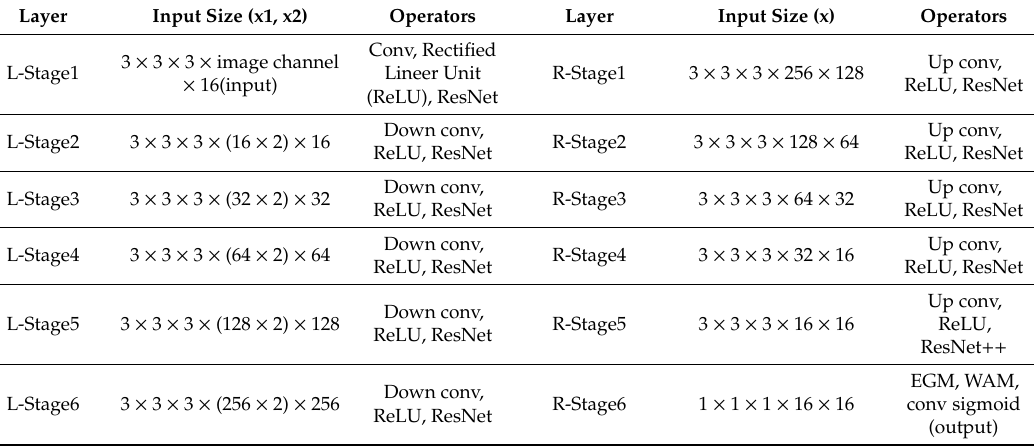
Table 1. Hybrid V-Net model architecture.